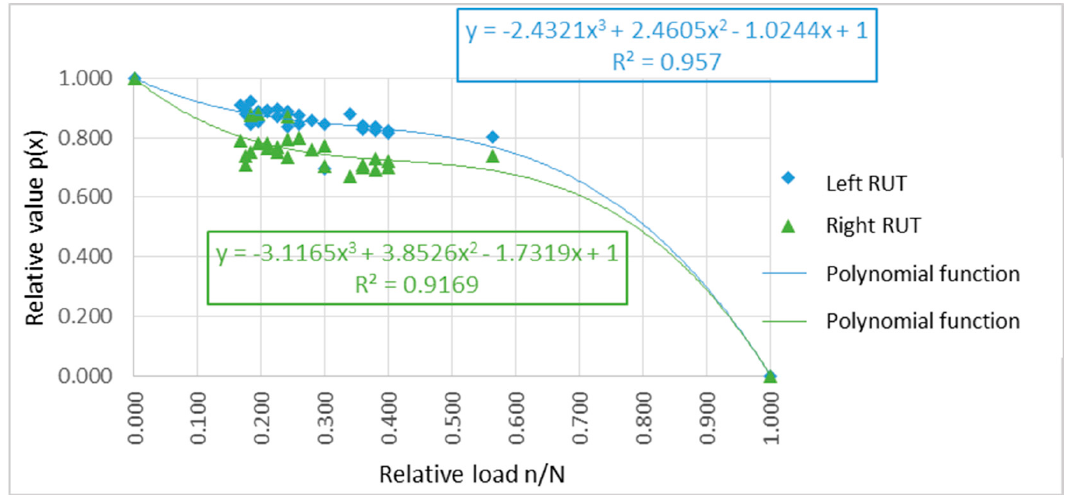
Figure 7. Degradation of the rut depending on the load n/N.